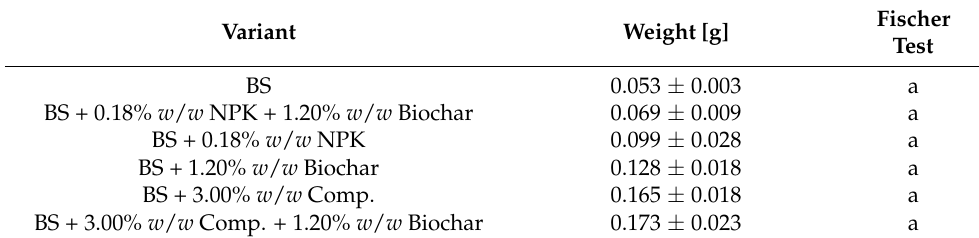
Table 4. Mean weight of UGB in individual variants.